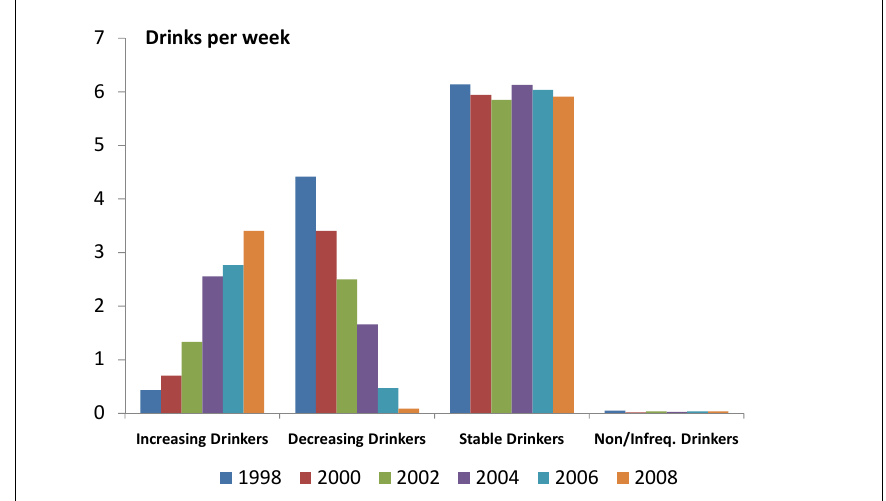
Figure 3. Numbers of drinks per week by trajectory group and year among 4,439 women in the HRS ages 50–65 years in